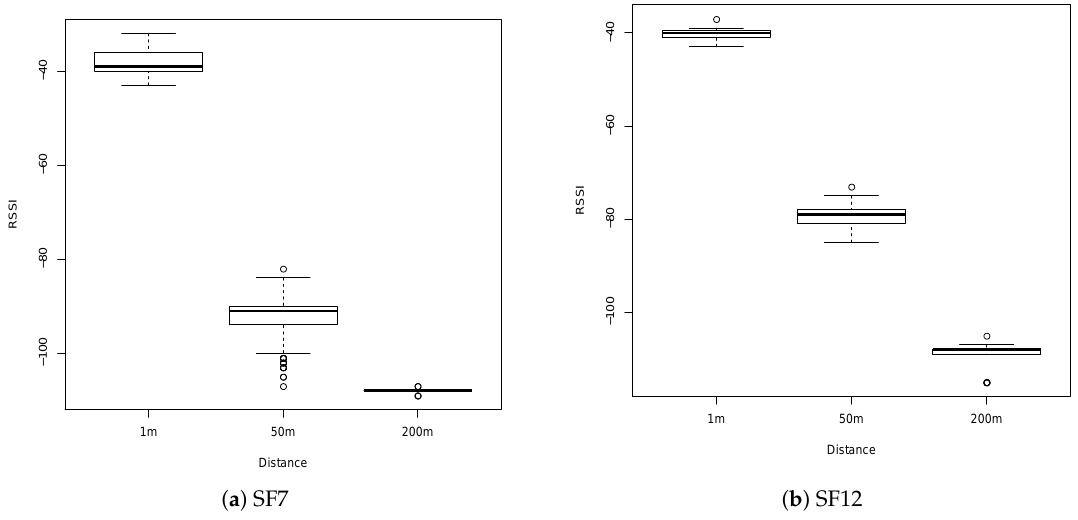
Figure 8. Variation and stability of the Received Signal Strength Indicator (RSSI) with two different spreading factors and three